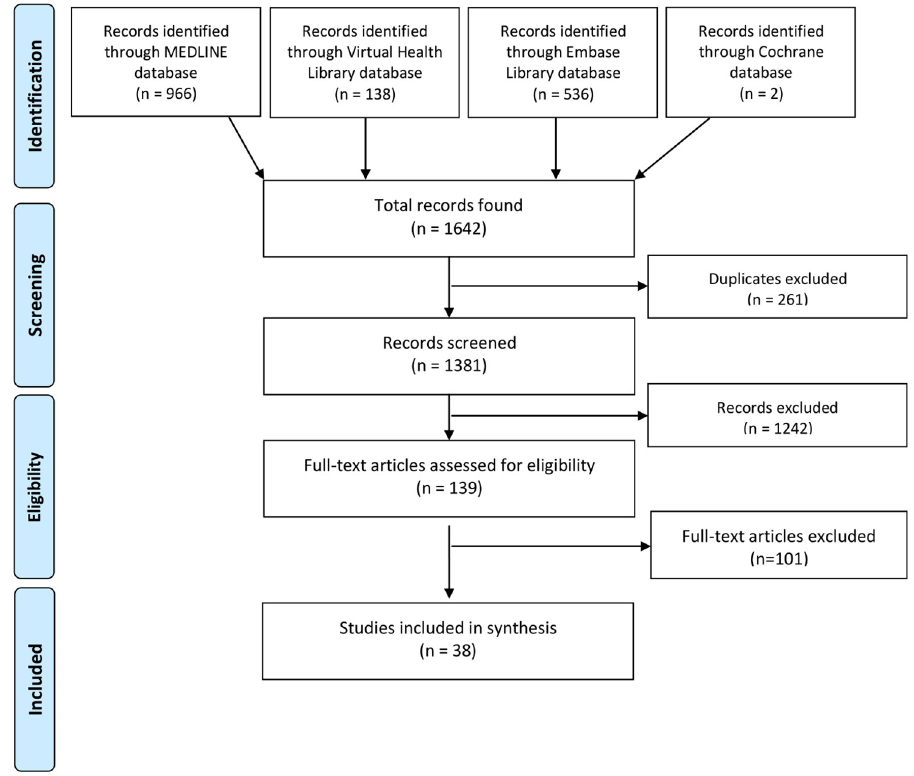
Fig 1. Flow diagram illustrating the study selection process according to